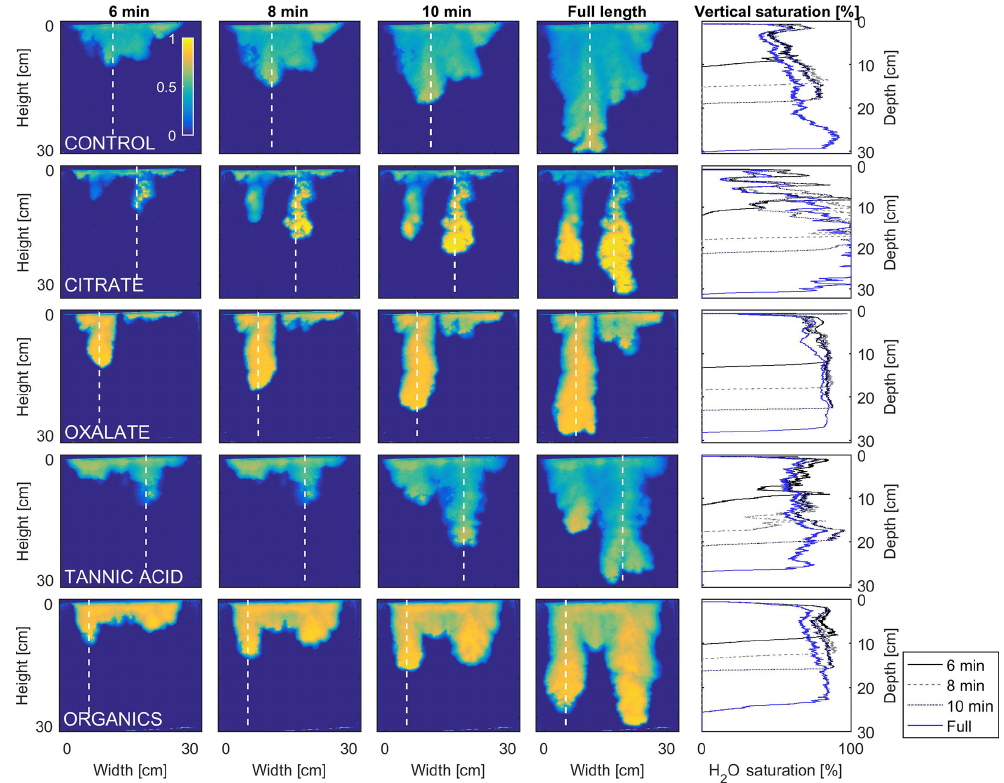
Figure 9. Multigraph comparison of the dynamic vertical profiles of infiltration of water in US Silica C778 ASTM graded sand for control (NaCl + HNS), and low concentrations of plant exudates (citrate and oxalate) and soil components (tannic acid and organics: Suwanee River natural organic matter, SRNOM). The images are of the main finger and the vertical water saturation profile analysis over